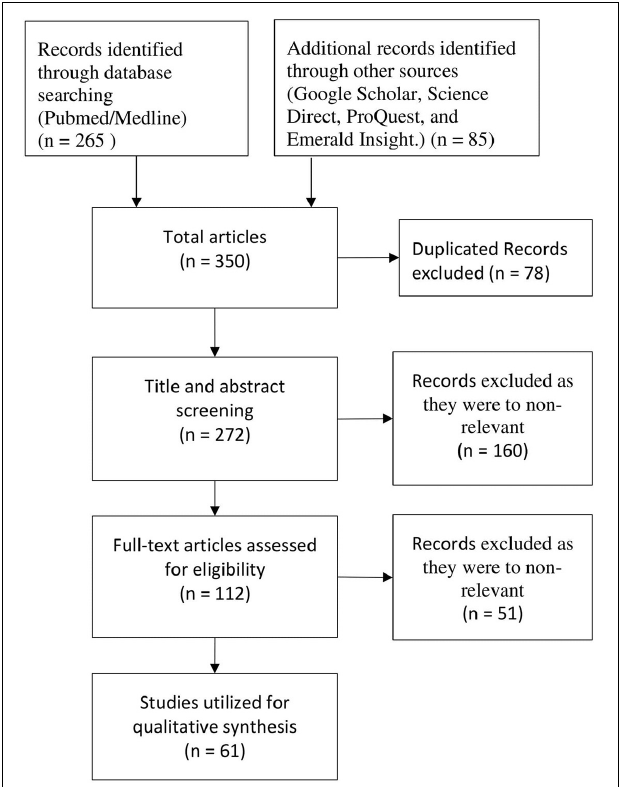
FIGURE 1 | Flow diagram illustrating the literature search and selection criteria (according to PRISMA, Preferred Reporting Items for Systematic Reviews and Meta-Analysis; Moher et al.,